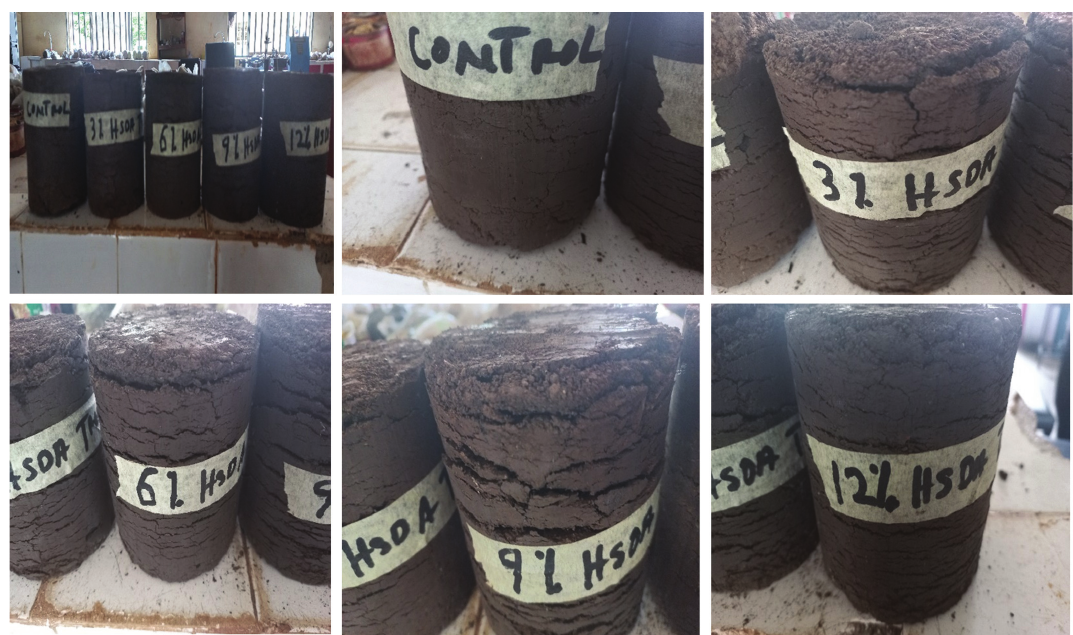
Figure 10: HSDA-treated black cotton soil crack development under drying at 102 ° C [35].